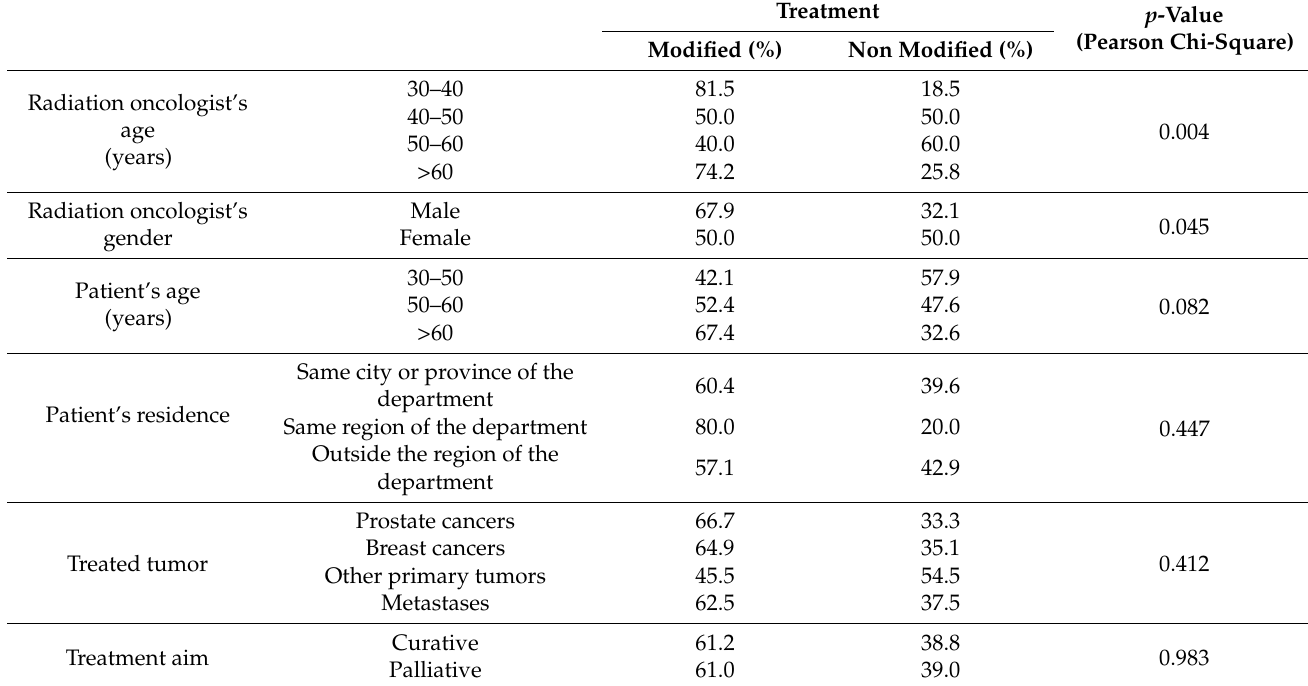
Table 1. Chi-square analysis: correlation between prescription modification and analyzed variables. Treatment p